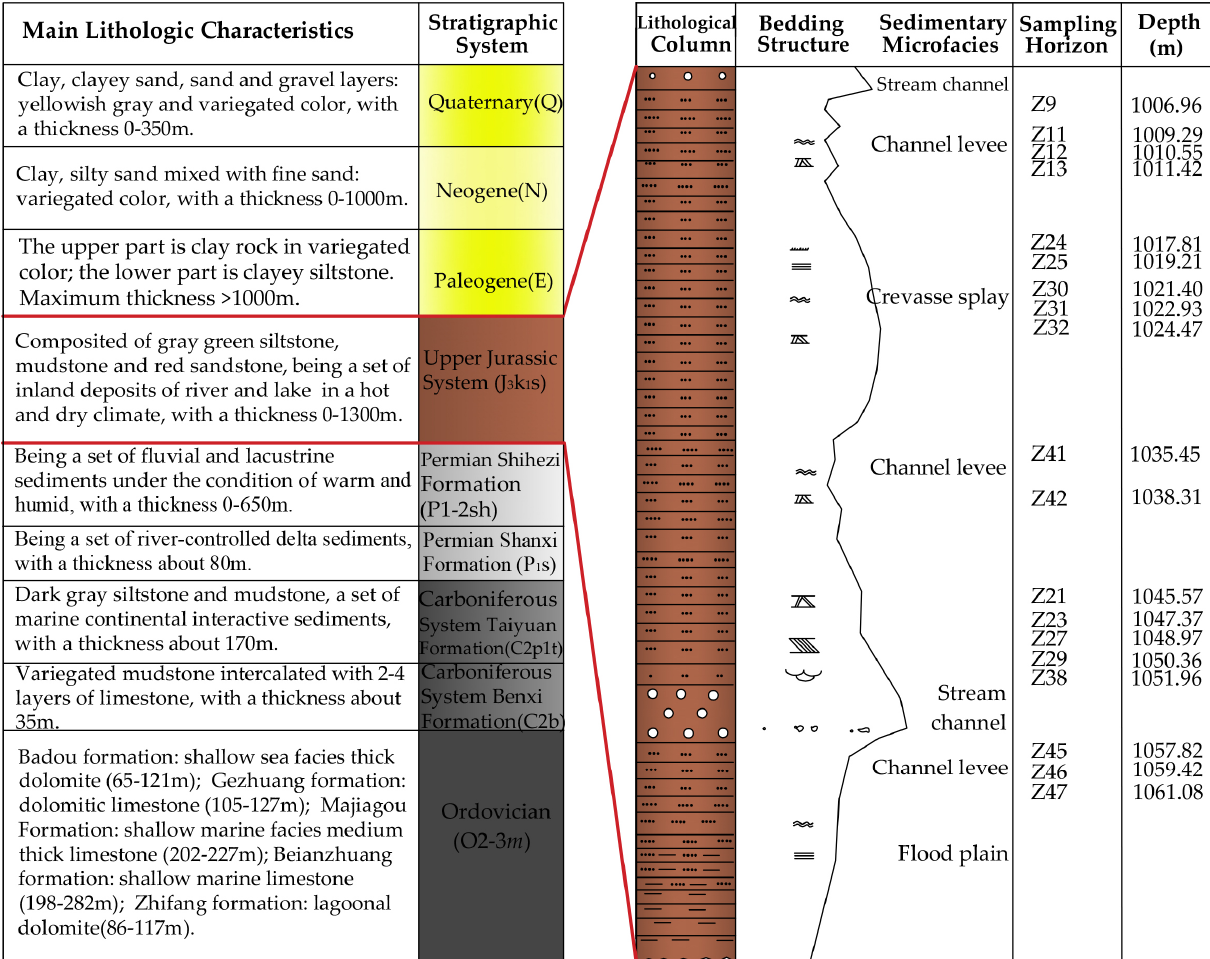
Figure 2. The sampling horizons and depths of the Permian Shihezi (P 1-2 sh) and Shanxi Formation (P 1 s) sandstone collected from the Anju coal mine of the Southwest Shandong coalfield: The gray column on the left shows the stratigraphic texture of P 1-2 sh in detail; The gray column on the right